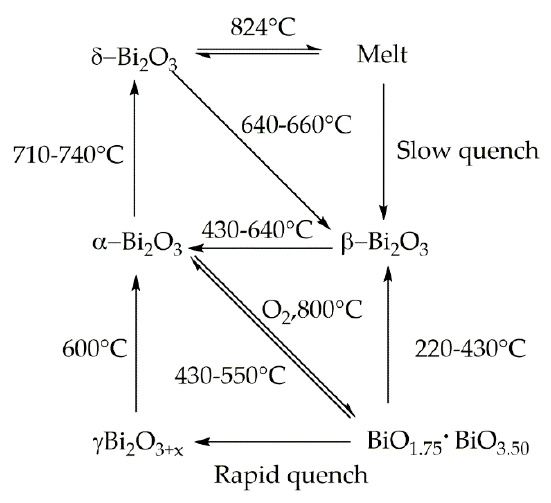
Figure 2. Scheme of phase transition of bismuth oxide.